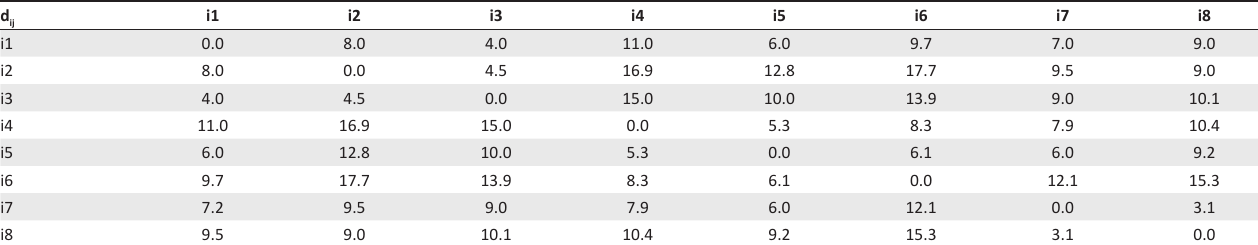
TABLE 3: Distance between collection centres.